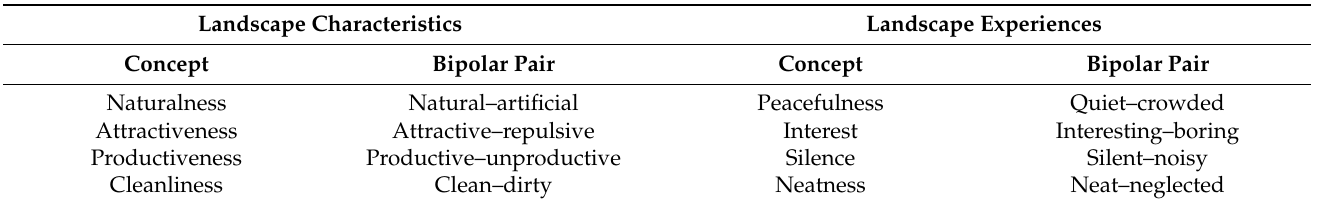
Table 1. Concepts used to pinpoint landscape perceptions and bipolar pairs they break down